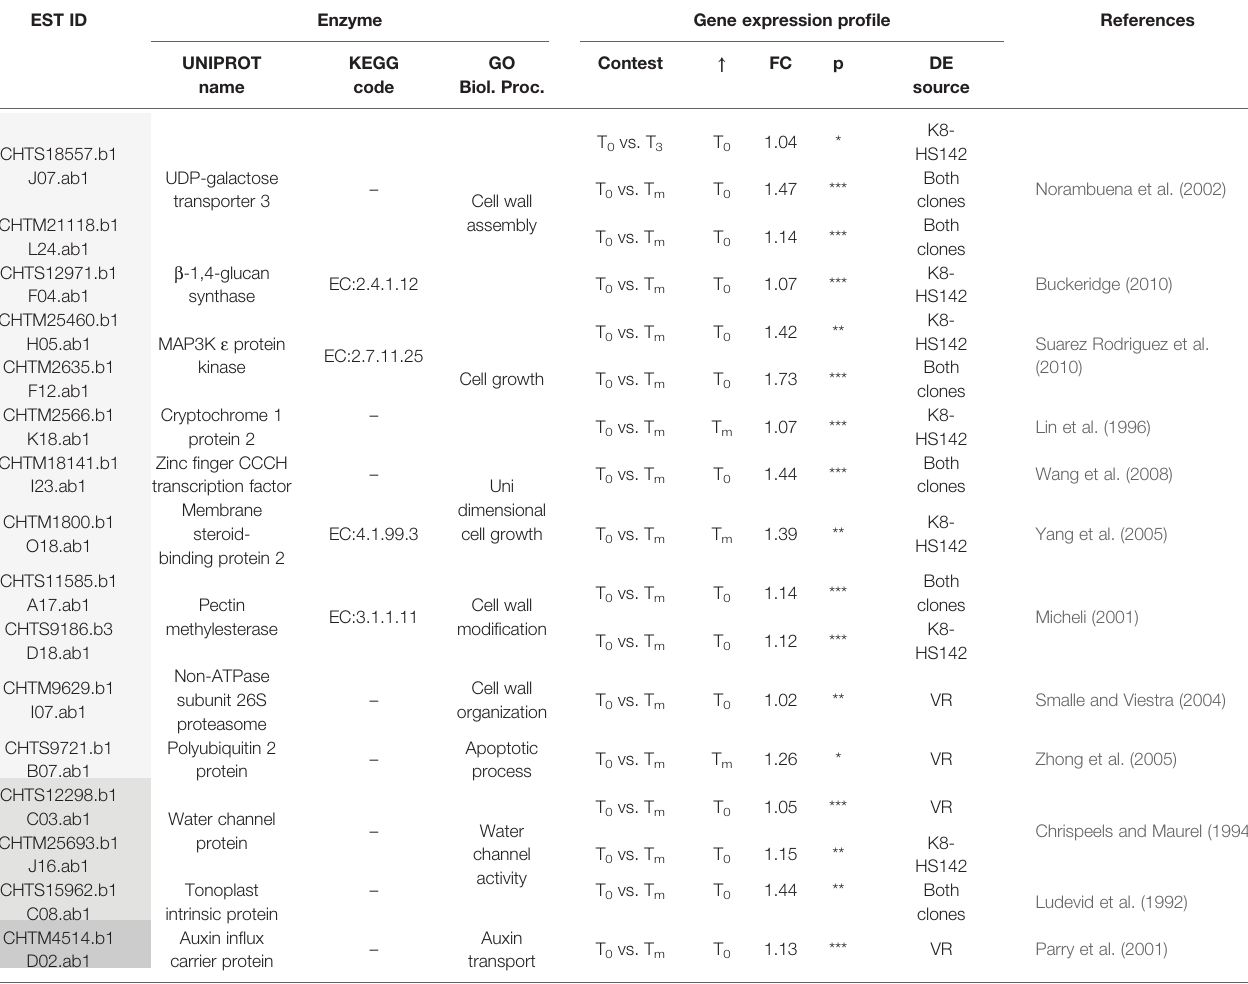
TABLE 7 | Differentially expressed (DE)/expressed sequence tags (ESTs) between tuber stages taking a role in cell development. EST ID